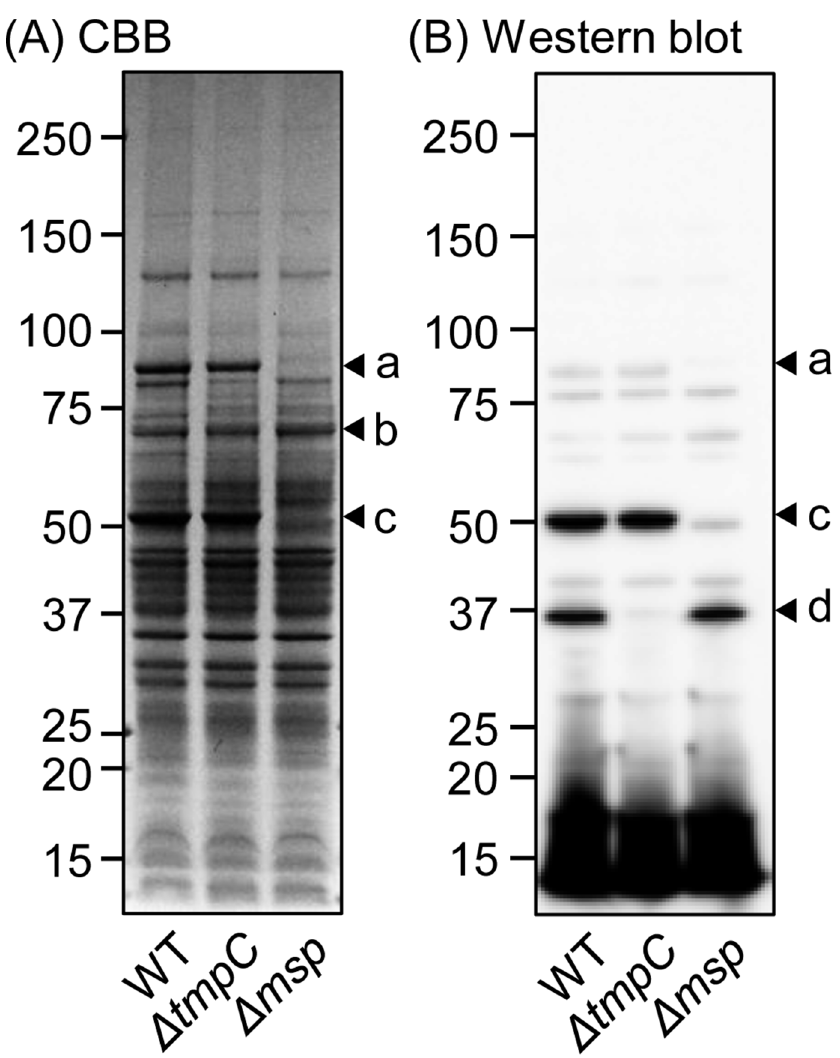
Figure 2. Protein patterns of T . denticola strains. The whole-cell lysates of the wild type (WT), D tmpC, and D msp were applied to SDS-PAGE (5– 20% gradient gel) followed by CBB-staining (A) and western blotting using anti- T . denticola antiserum (B). Panel (A) shows that TDE1072 (a) and Msp (c) were absent in D msp . Western blot analysis confirmed deficiencies of TmpC (d) and Msp (c) in D tmpC and D msp , respectively. The arrowhead b in panel A was identified as OppA. Molecular-weight standards (kDa) are shown at the left. doi:10.1371/journal.pone.0113565.g002 (Fig. S1). All strains exhibited substantial adherence, but no